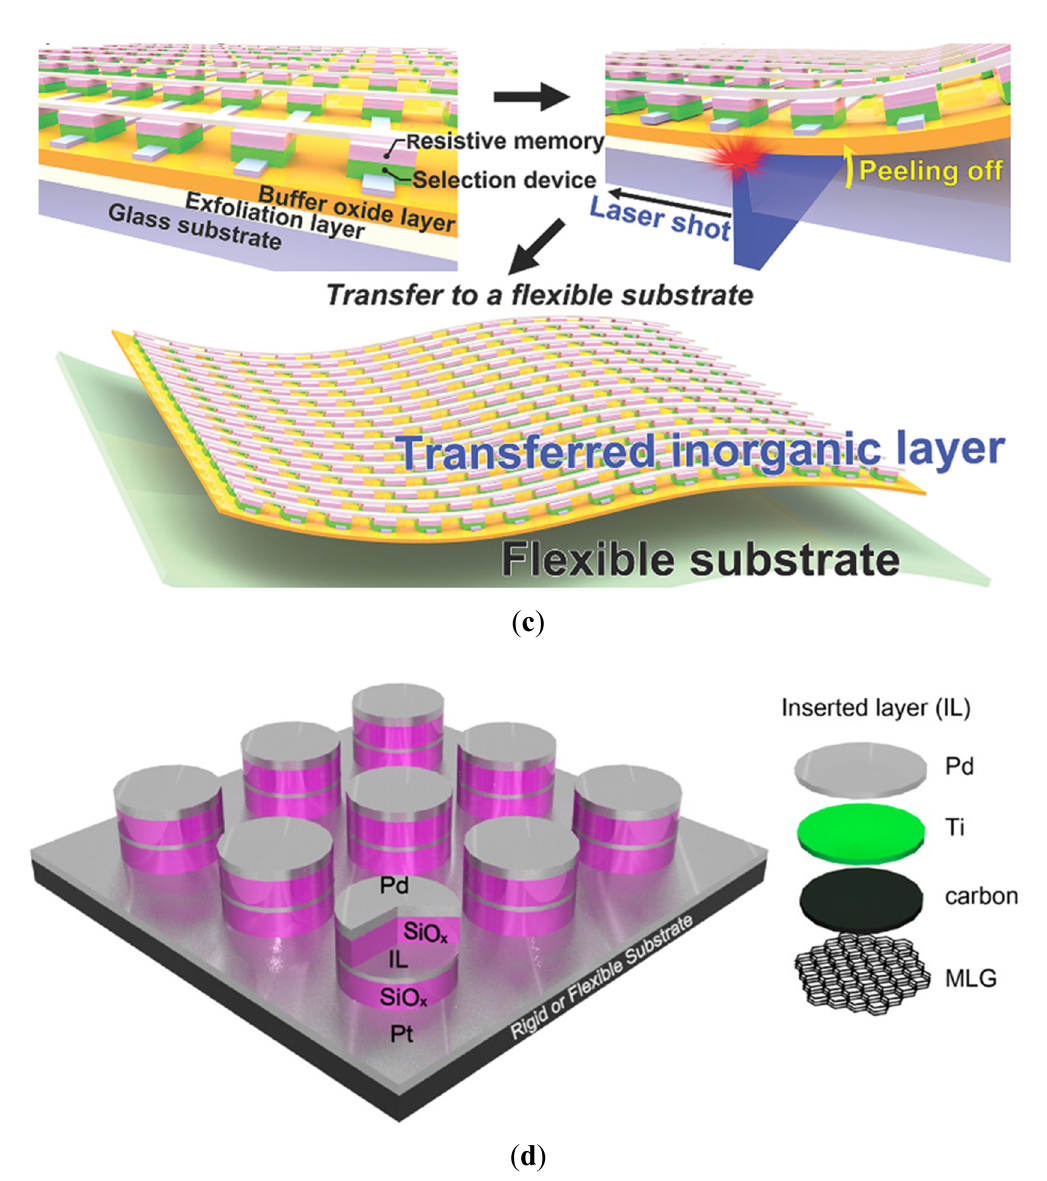
Figure 3. ( a ) Schematic illustrations of three basic modes for transfer printing. Reprinted with permission from [23]. Copyright © 2012 WILEY-VCH Verlag GmbH & Co.; ( b ) schematic diagram of the fabrication procedures for the freestanding OFETs using modified water-floatation method. Reprinted with permission from [30]. Copyright © 2013 WILEY-VCH Verlag GmbH & Co.; ( c ) schematic illustrations of the process for fabricating flexible crossbar-structured memory on a plastic substrate via the laser lift-off transfer method. Reprinted with permission from [32]. Copyright © 2014 WILEY-VCH Verlag GmbH & Co.; ( d ) schematic illustration of the cells in the conducting-interlayer SiOx memory device sputtered at room temperature. Reprinted with permission from [33]. Copyright © 2014 WILEY-VCH Verlag GmbH &